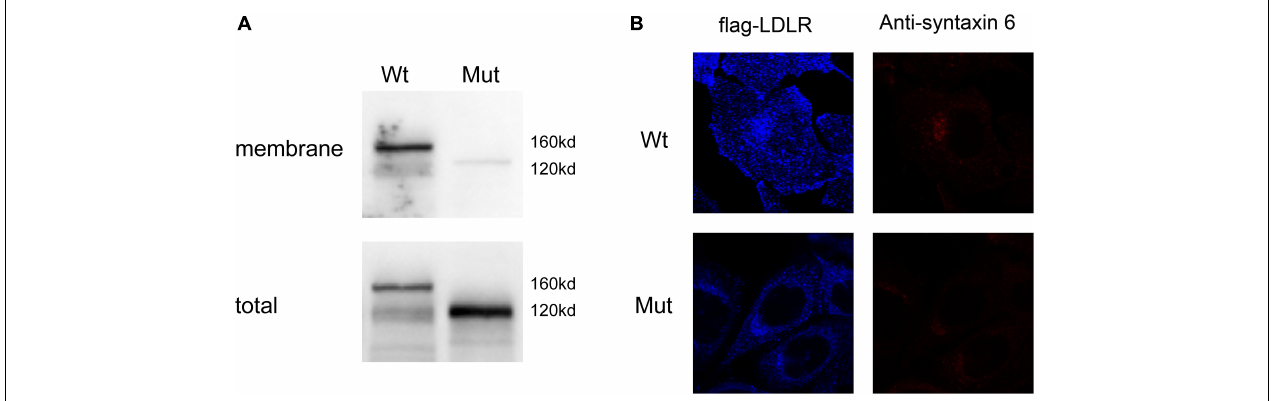
FIGURE 3 | Expression of different LDLR variants on cell surface of HepG2-transfected cells. (A) Western blot analysis showed that mutant LDLR protein with exon 16 deletion was rarely expressed on membrane but accumulated in plasma of HepG2 cells with a molecular weight of 120 kDa. Membranous LDLR was analyzed by biotinylation as described in section “Analysis of Surface Biotinylated Proteins and Western Blotting.” (B) CLSM examination showed that WT LDLR was mainly distributed at cell surface, whereas mutant LDLR with exon 16 deletions was mainly retained in Golgi apparatus. Blue fluorescence represents distribution of Flag antibody. Because Flag gene and LDLR gene are fused, blue fluorescence distribution reflects distribution of LDLR protein in cell (LDL-R). Red fluorescence indicates the position of Golgi apparatus (marked with anti-syntaxin